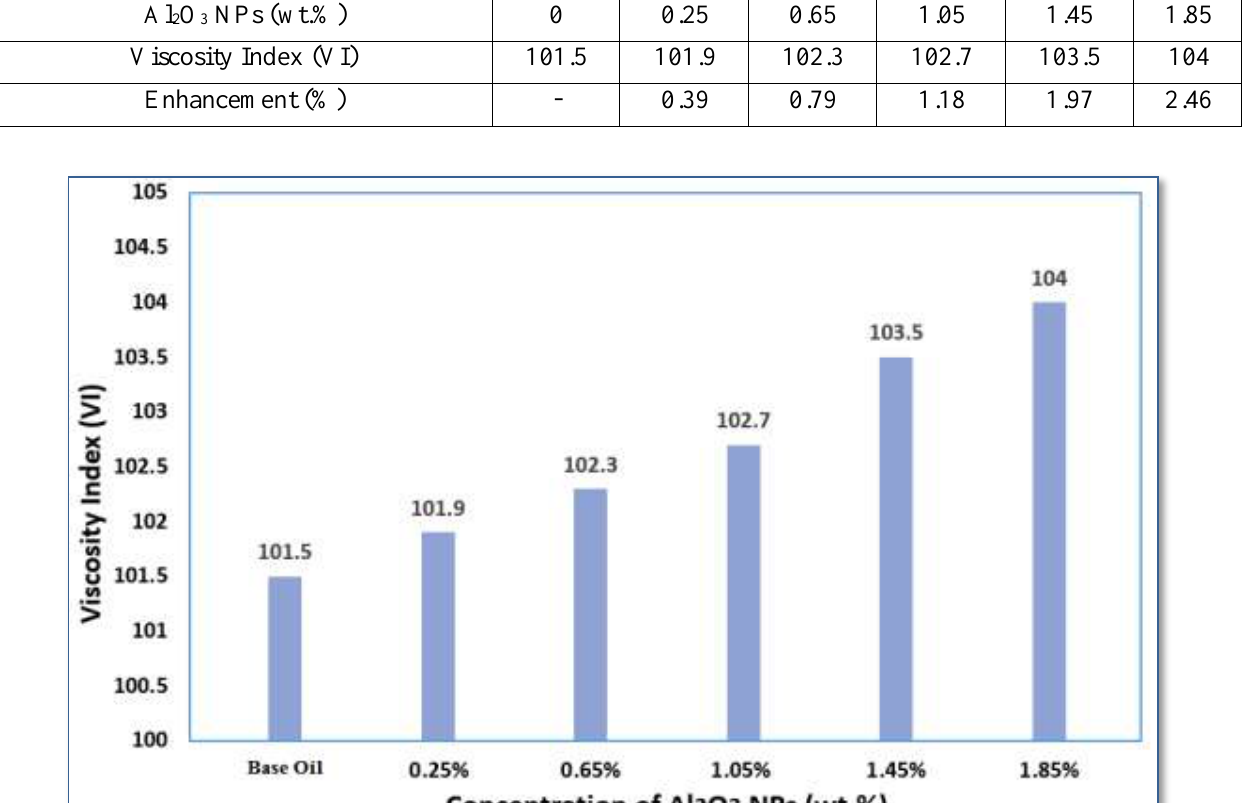
Table 3: The measured VI values of nano-lubricating oil at various additions of Al 2 O 3 NPs. Al 2 O 3 NPs (wt.%)